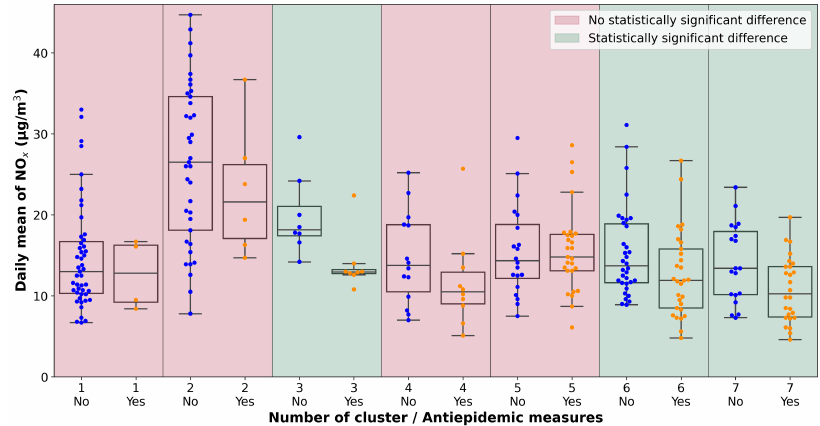
Figure 11. Results of the ANOVA test, Vˇeˇrˇnovice, NO x .